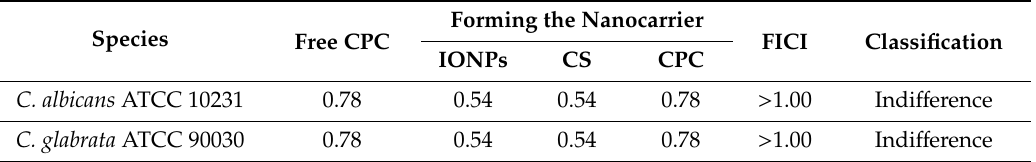
Table 1. Minimum inhibitory concentration (MIC, µ g mL − 1 ) values of free cetylpyridinium chloride (CPC) or forming the nanocarrier in conjunction with iron oxide nanoparticles (IONPs) and chitosan (CS), against Candida strains.